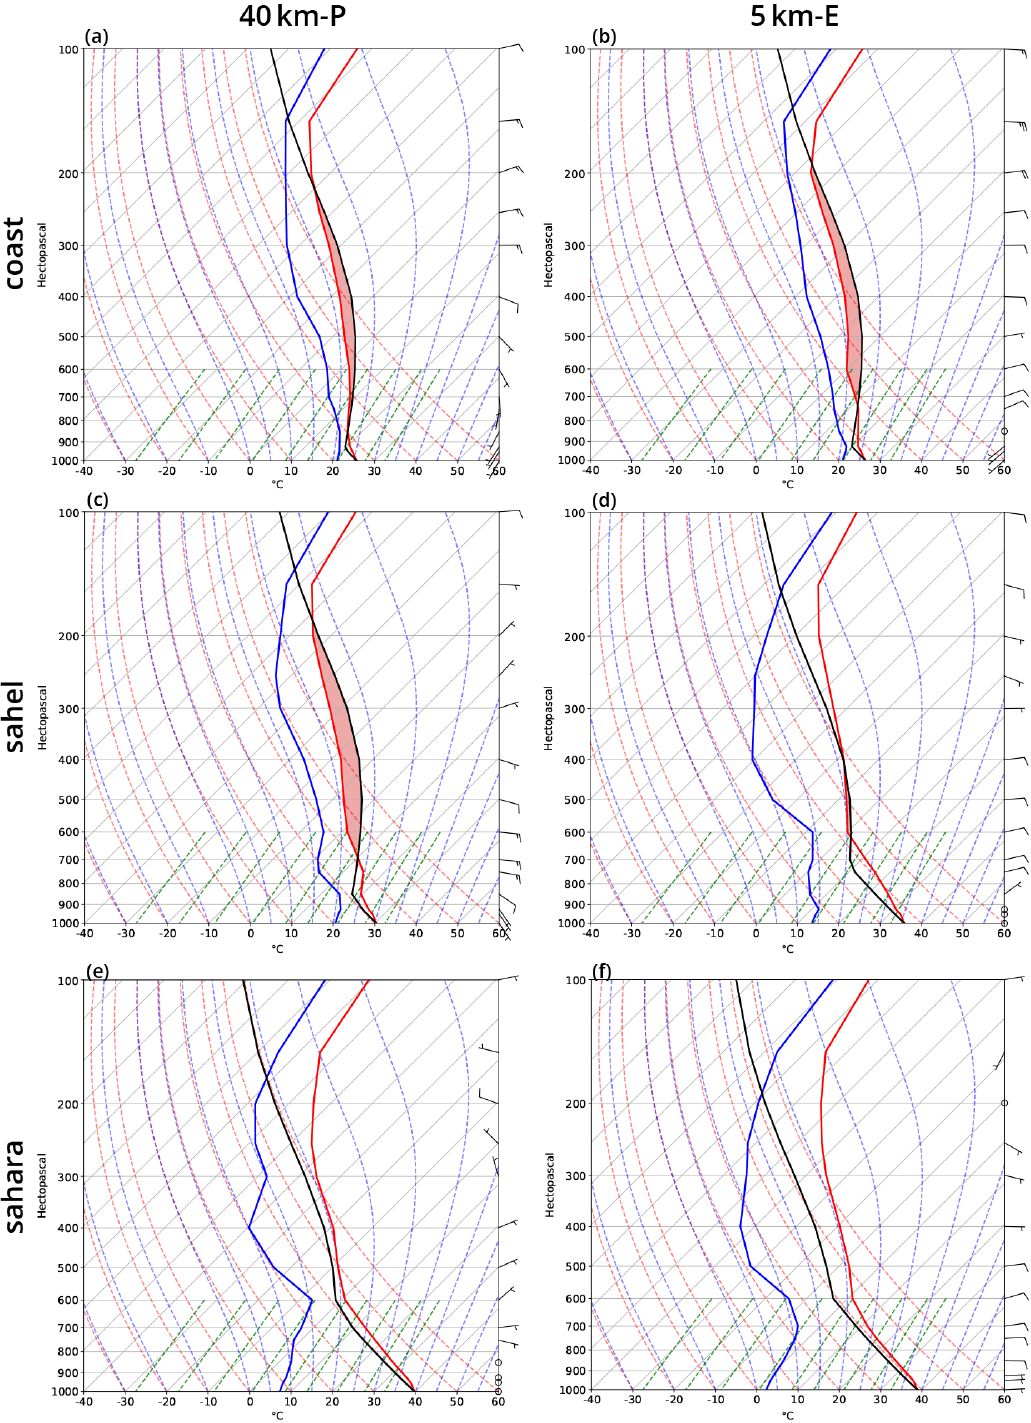
Figure 7. Skew-T diagrams for 8 September 7023BP 12:00UTC for the 40km-P (a, c, e) and the 5km-E (b, d, f) simulations. The red line depicts the temperature profile, the blue line the dew point and the black line the path an air parcel would take through the atmosphere. The profiles are averaged over the three domains outlined in Fig. 1 labeled with “coast”, “Sahel” and “Sahara”. The red-shaded area displays the CAPE. The lines in the background refer to the dry adiabats (dashed red), moist adiabats (dashed blue), isotherms (solid gray tilted) and isobars (solid gray